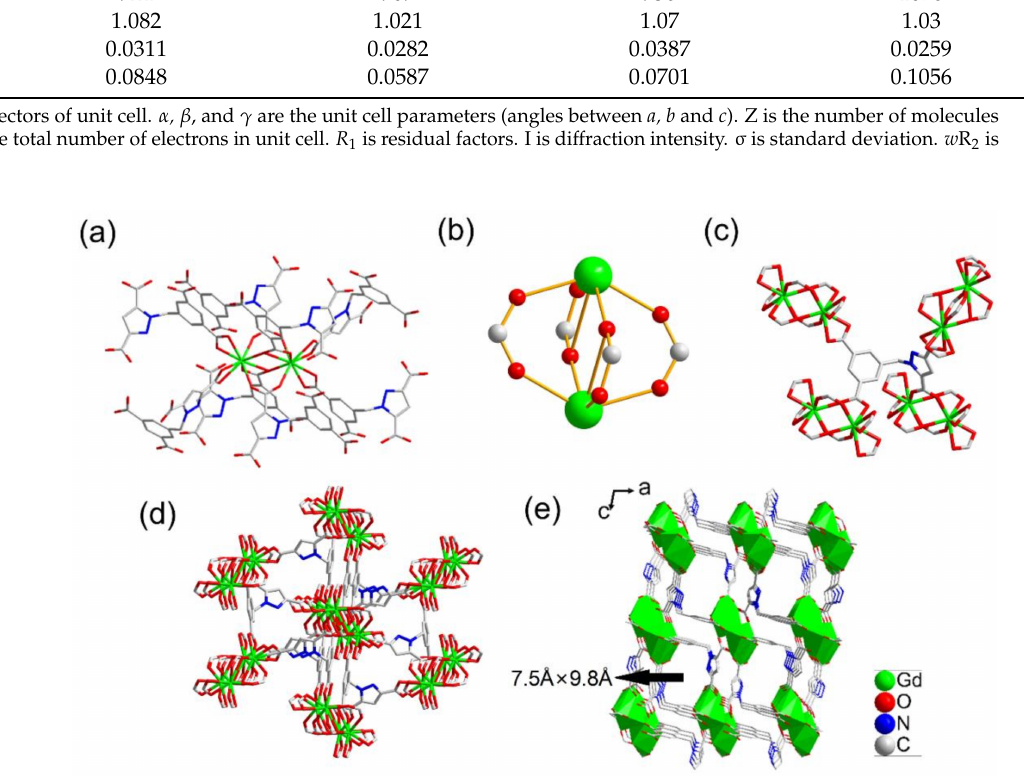
Figure 1. ( a ) Coordination environment of the Gd 3+ ion in Gd-metal-organic frameworks (MOF) (Gd, green, O, red, N, blue, C, gray). ( b ) The binuclear metal cluster unit [Gd 2 (COO) 4 ]. ( c ) The coordination mode of the [L] 4 − ligand. ( d ) The coordination mode of the binuclear metal cluster unit [Gd 2 (COO) 4 ]. ( e ) The 3D framework viewed along the b-axis. Topological analysis [38] shows that the structure can be simplified as a new (4, 8)- connected net with stoichiometry (4 − c) (8 − c) 2 and point symbol of {4 10 .6 14 .8 4 } {4 5 .6} 2 when the binuclear metal cluster units and ligands are considered as eight-connected nodes and four-connected linkers, respectively (Figure 2). Powder X-ray diffraction (PXRD) patterns were then recorded to analyze the phase purity of the obtained compounds. The results reveal that the samples of four MOFs are of high purity (Figure